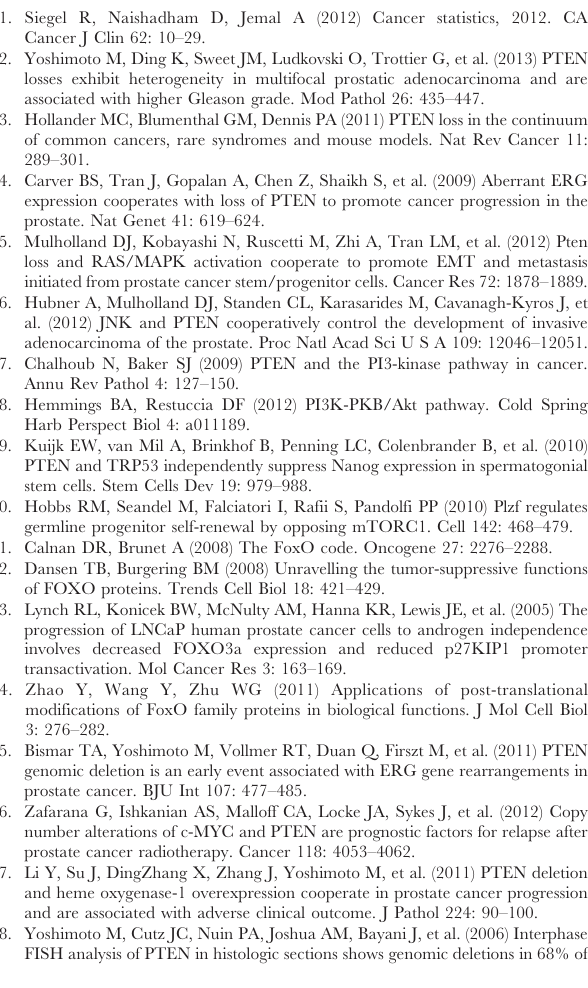
Figure S1 The formation of tumor in PTEN knock-out mice. The representative images of the tumor formed in one flank of testis (arrow) in PTEN knock-out mice. Table S1 Summary of PTEN, PLZF and FOXO3a staining scores in human PCa